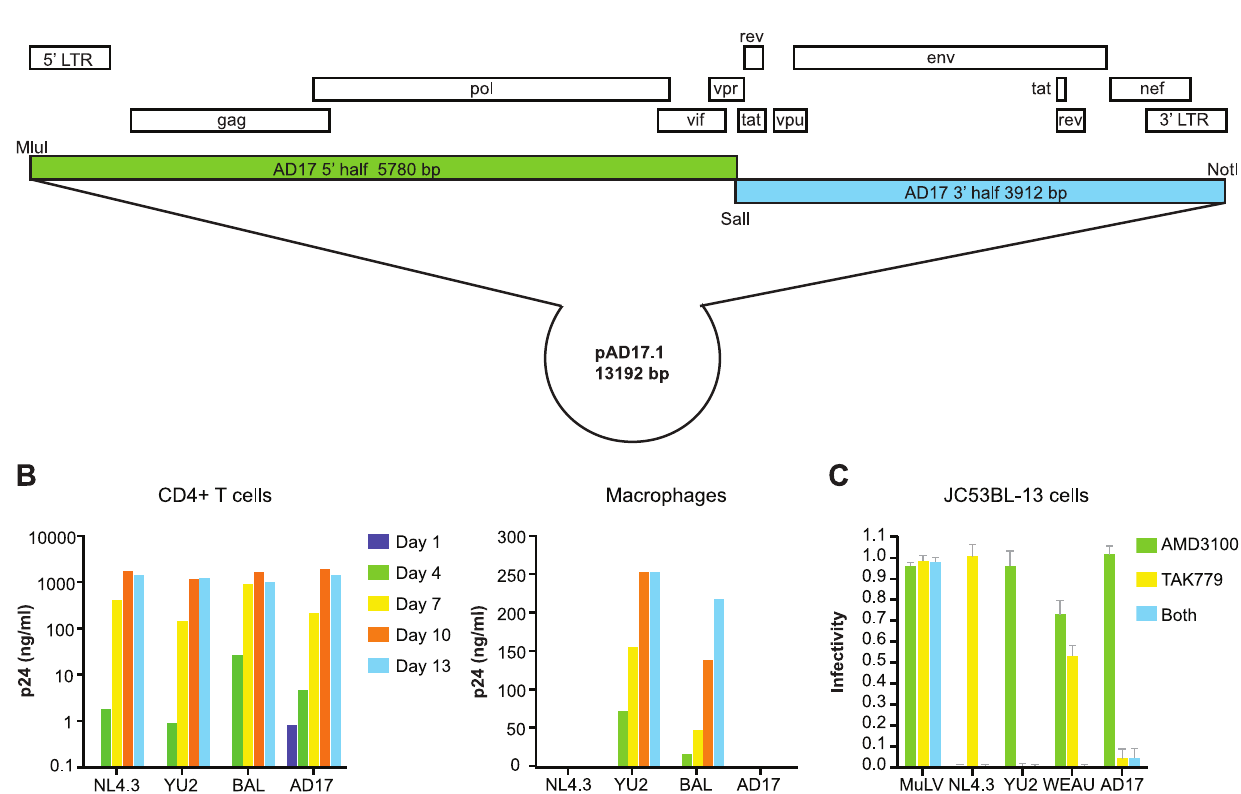
Figure 5. Molecular cloning and biological analysis of the transmitted/founder virus from subject AD17. ( A ) Cloning strategy and genome organization of the transmitted/founder HIV-1 provirus pAD17.1. ( B ) Replication of pAD17.1 virus in activated primary human CD4 + lymphocytes (left panel) and monocyte-derived macrophages (right panel) from the same normal blood donor. Results were replicated three times in cells from different donors, each time showing efficient replication of pAD17.1 virus in CD4 + T cells but not in macrophages. ( C ) pAD17.1 virus infection of JC53BL-13 cells assessed by luciferase expression [12] in the absence or presence of the CXCR4 inhibitor AMD3100 (1.2 uM) or the CCR5 inhibitor TAK779 (10 uM) or both. Results from four experiments are expressed as infectivity (mean 6 1 S.D.) relative to control wells lacking coreceptor inhibitor: NL4.3 is X4 tropic, YU2 is R5 tropic, WEAU1.60 is dual R5/X4 tropic, and pAD17.1 is R5 tropic.